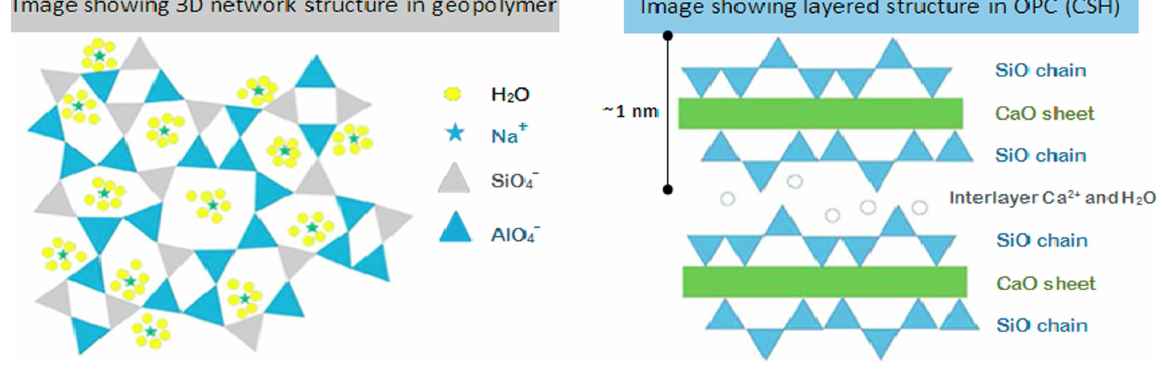
Figure 1: Schematic molecular structure of geopolymer in contrast to OPC [8]